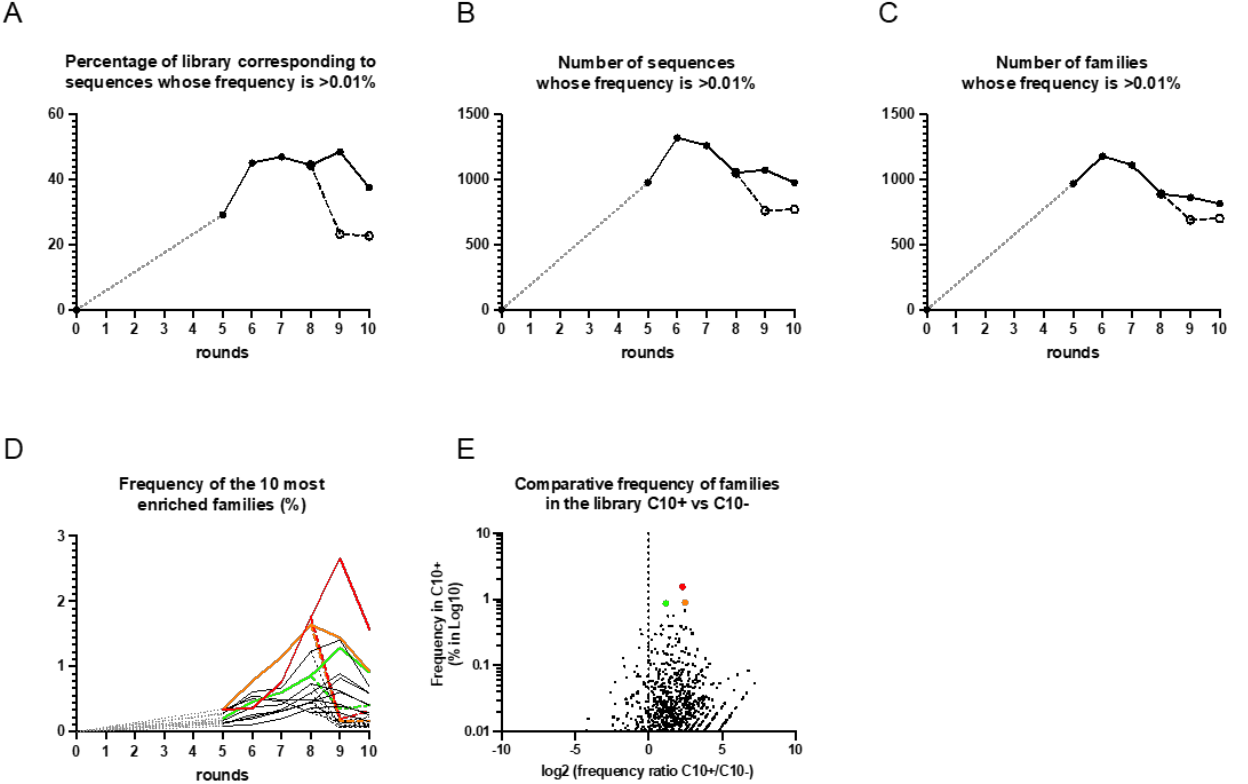
Figure 3. Deep sequencing analysis of SELEX. The starting library and the libraries after cycle 5 were analyzed. Sequences whose frequency is higher than 0.01% at least in one cycle were recovered and their percentage in the library as well as their number were measured for several cycles ( A , B ), respectively). Those sequences have been clustered in families based on an edit distance of 6. The evolution of the number of families is presented in ( C ). The frequency of the 10 most enriched families is presented in ( D ). The frequency of each family in the last C1+ cycle relative to its enrichment in the presence or absence of the HE4 protein (C10+/C10 − ratio) is presented in ( E ). The evolution in solid lines and black dots correspond to libraries from positive selection in the presence of HE4 protein, while the evolution of dashed lines and light dots correspond to the two cycles without protein. The gray dotted lines correspond to cycles that were not sequenced. The colored curves and dots correspond to the evolution of the 3 families which were selected for binding evaluation (red, orange and green for AHE1, AHE2 and AHE3, respectively).